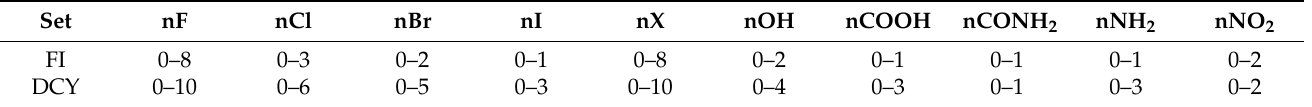
Table 1. The range of the number of major substitution groups for the structures included in the two sets (FI,